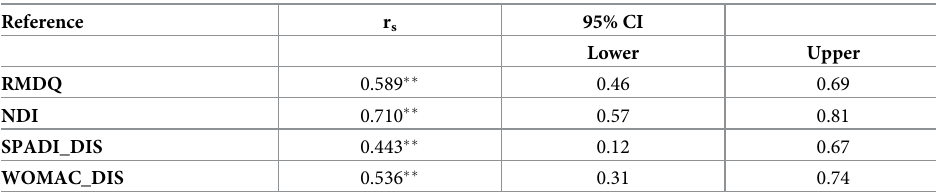
Table 3. Correlations STarT-MSK G against disability